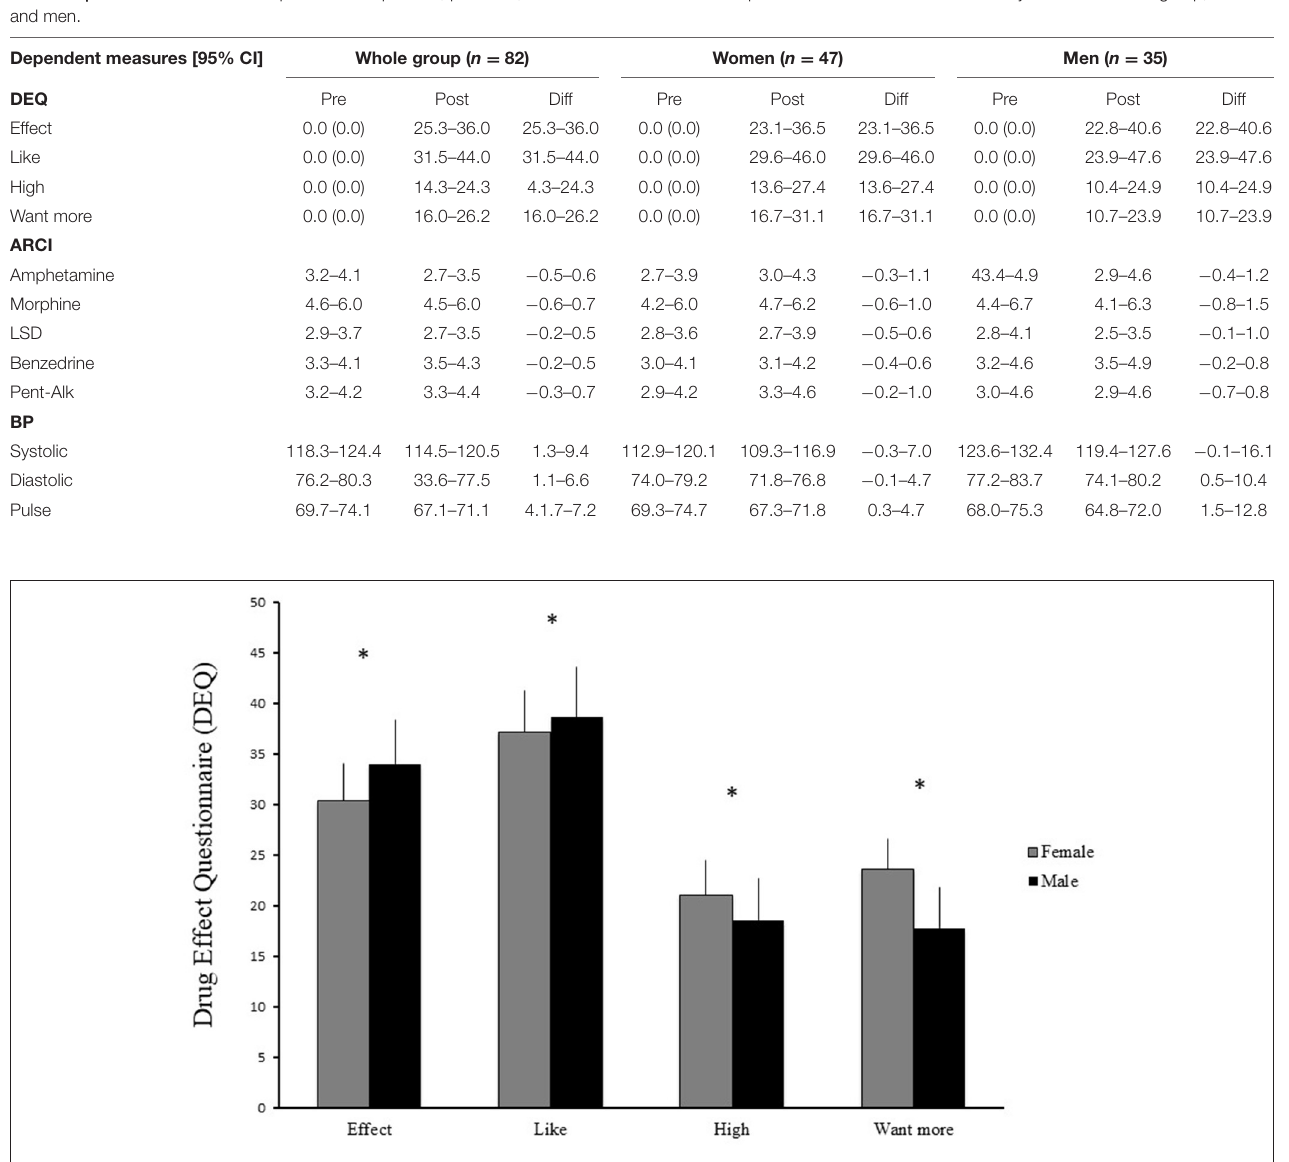
FIGURE 1 | Mean difference scores and standard error of mean (SEM) on the Drug Effects Questionnaire (DEQ) between pre and post-test for Effect, High, Like, and Want more after the 10min online slot machine task between men (black bars) and the women (gray bars). The asterisks denote significant differences between pre and post-test ( p < 0.05) for the data of the whole